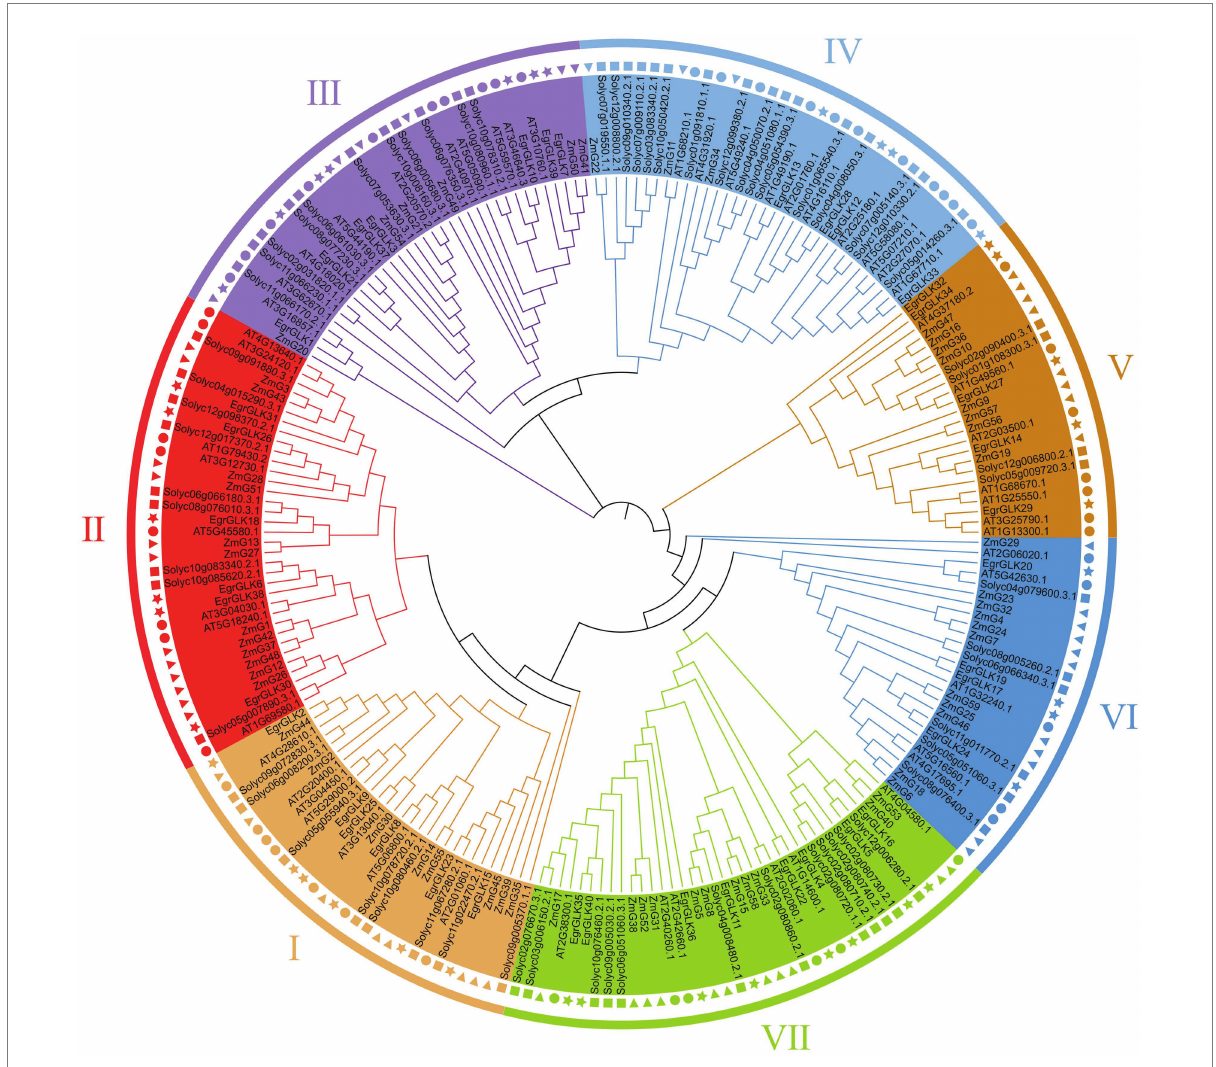
FIGURE 3 Phylogenetic analysis of GLK proteins from E. grandis , maize, Arabidopsis , and tomato. Different GLK protein groups are indicated by different colors. The star, triangle, circle, and square represent E. grandis , maize, Arabidopsis , and tomato GLK proteins,